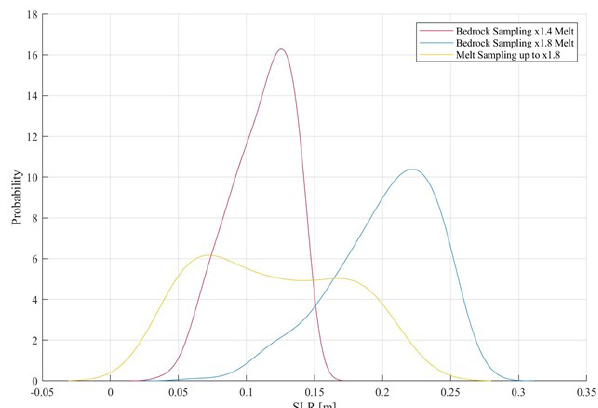
Figure 5. Distributions of event probability as a function of SLR contribution after 200 years of simulation for three different bound- ary condition sampling experiments, each experiment consisting of 300 model simulations. Experiments include sampling of bedrock topography under two different ocean warming scenarios: one model scenario with a basal melt multiplier of × 1 . 4 (pink) and one model scenario with a basal melt multiplier of × 1 . 8 (blue). For comparison, we also present results from sampling of basal melt rates between × 1 and × 1 . 8, with no changes in bedrock topogra- phy